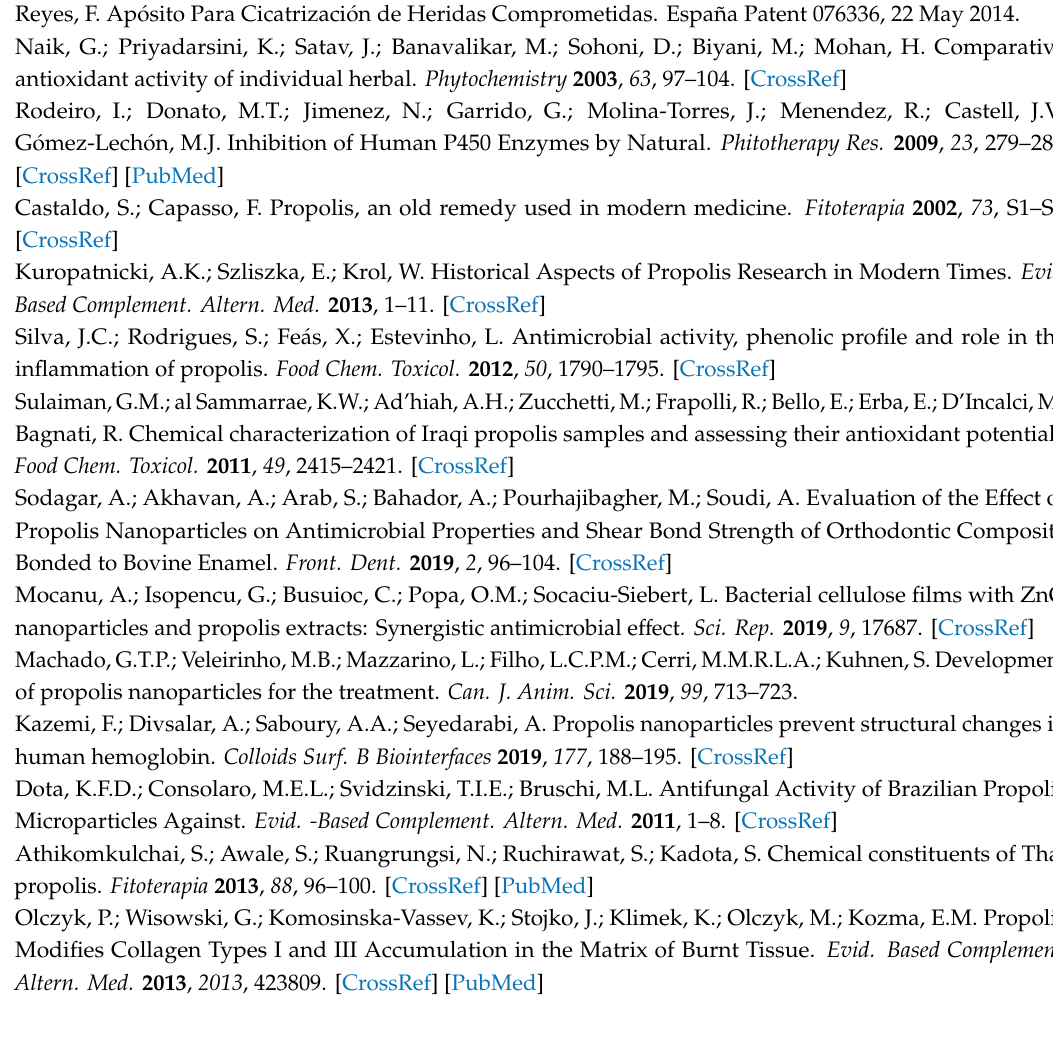
Figure S1: AFM (A) amplitude, (B) phase image of the collagen control sample. (C) Cross- section of the line profile shown in A. The collagen D-pattern gap is similar in all the microfibers measured and all the microfibers show a homogeneous